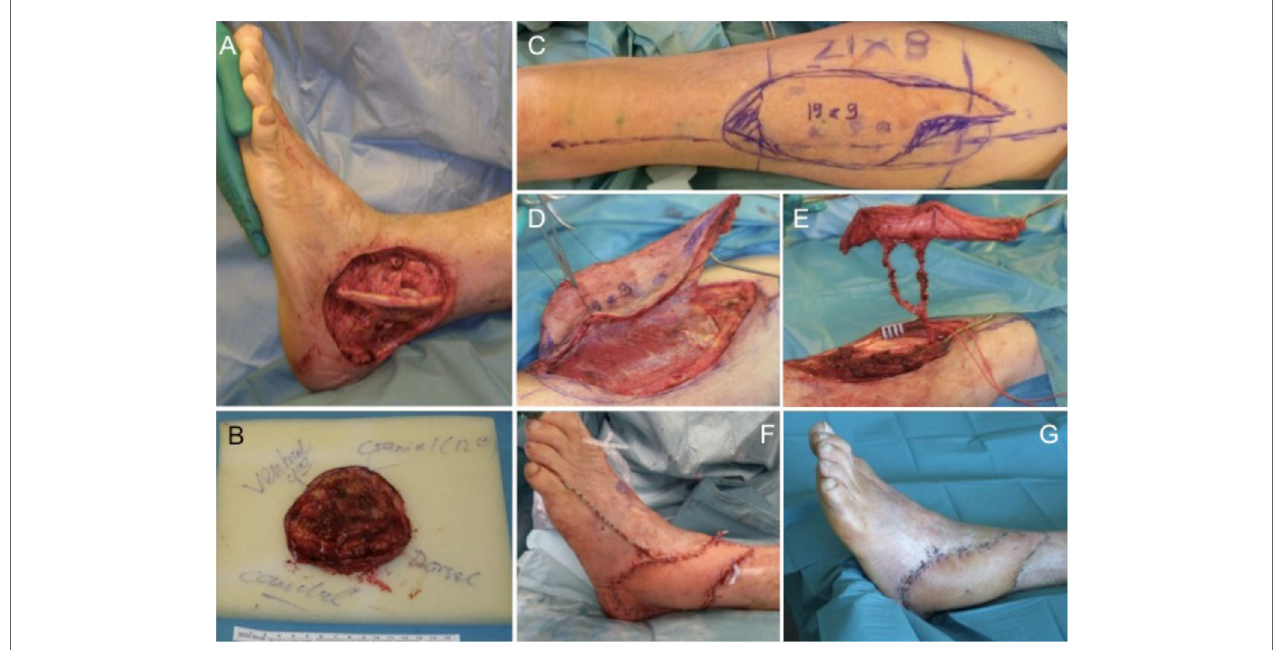
FiGURe 5 | extensive soft tissue defect at the lateral malleolus (A) after tumor excision (B) . For wound coverage, an ALT flap is prepared (C,D) with a long pedicle (e) for microvascular anastomosis. The ALT flap engrafted into the defect shows intraoperatively (F) and after wound healing a very satisfying result (G)